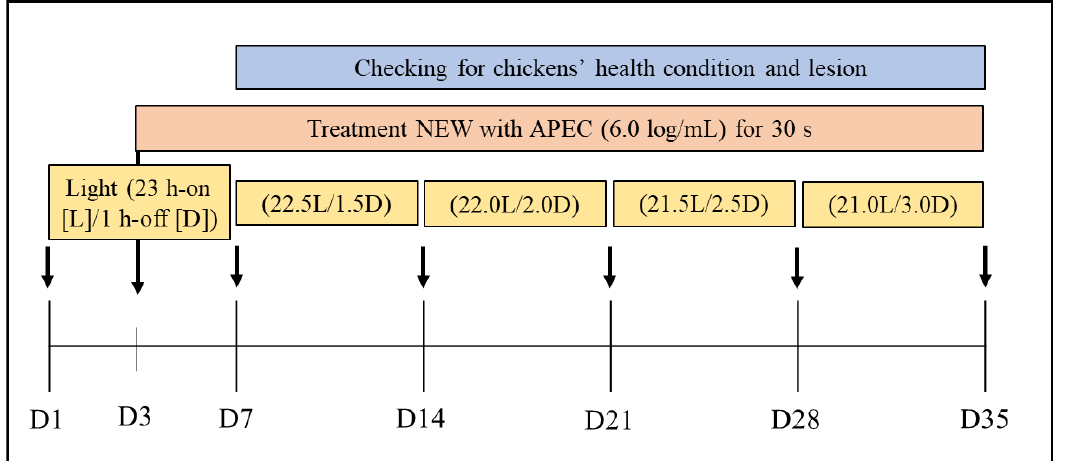
Figure 2. Experimental design and schedule for the antimicrobial activity of NEW against APEC. Male layer chickens in treatment groups were daily exposed to 50 mL of APEC strains (1.0 × 10 6 cfu/mL), followed by 50 mL of NEW (100 ppm free chlorine) with a novel high-pressure sprayer or a conventional sprayer after day 3. The experimental chicks were illuminated with a 23 h light and 1 h dark–light schedule throughout a week’s experimental period. Half hour for dark time was then increased weekly until day 35. At least four layers in the chambers from each group were sacrificed weekly to evaluate APEC infection via observation of colibacillosis